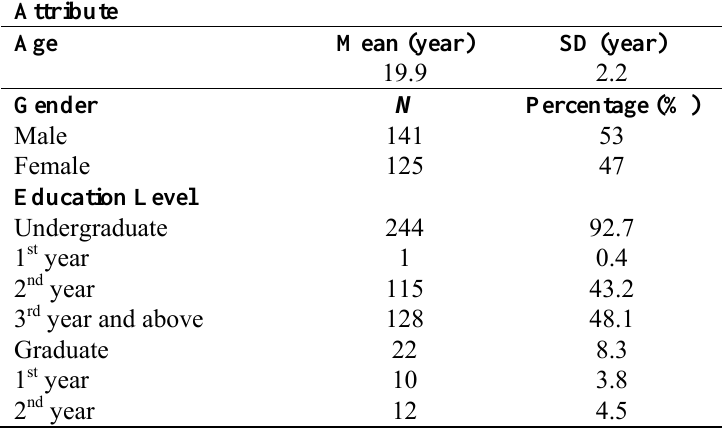
Table 1. Respondent Profiles ( N =